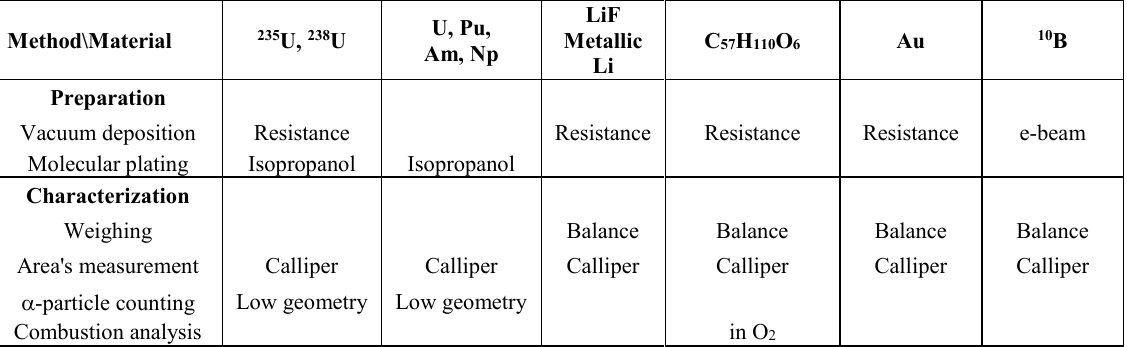
Table 2. Overview of the present preparation and characterization techniques for thin targets.